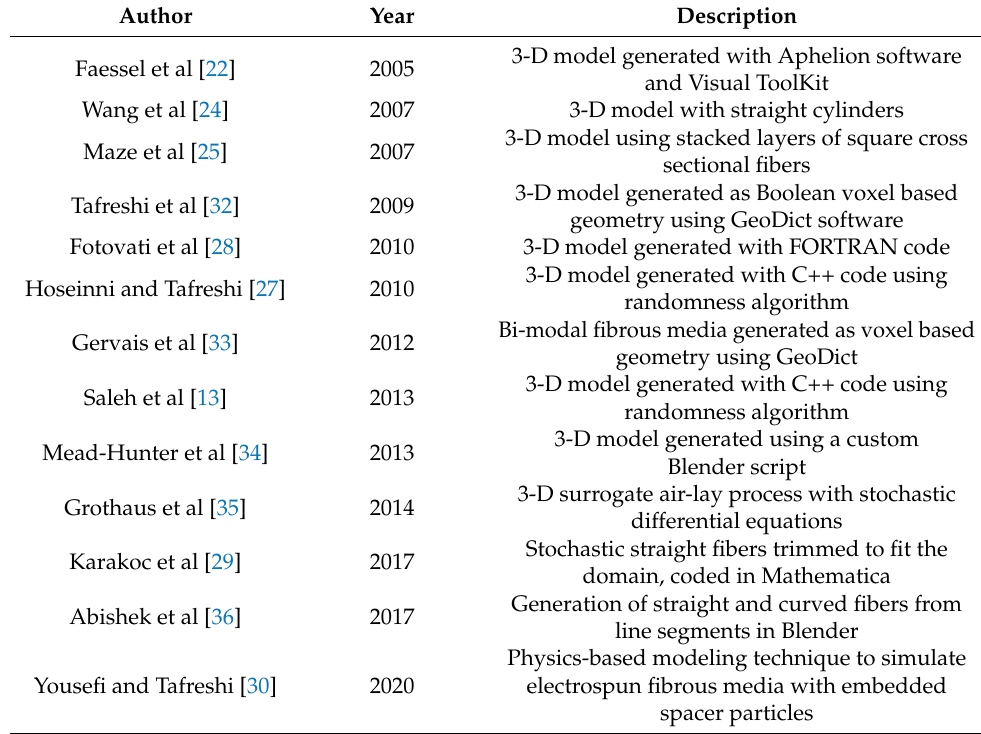
Table 1. Significant efforts constructing three-dimensional digital twin air filter